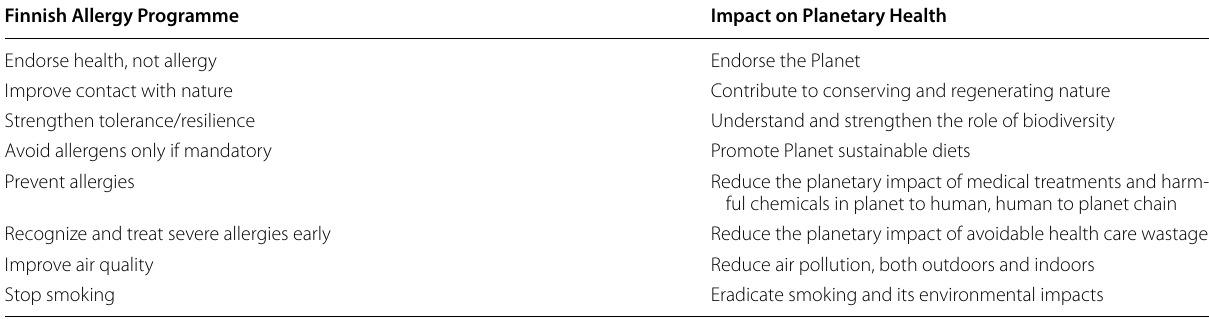
Table 1 Potential of the Finnish Allergy Programme to address Planetary Health Finnish Allergy Programme Endorse health, not allergy Endorse the Planet Improve contact with nature Strengthen tolerance/resilience Avoid allergens only if mandatory Prevent allergies Recognize and treat severe allergies early Improve air quality Stop